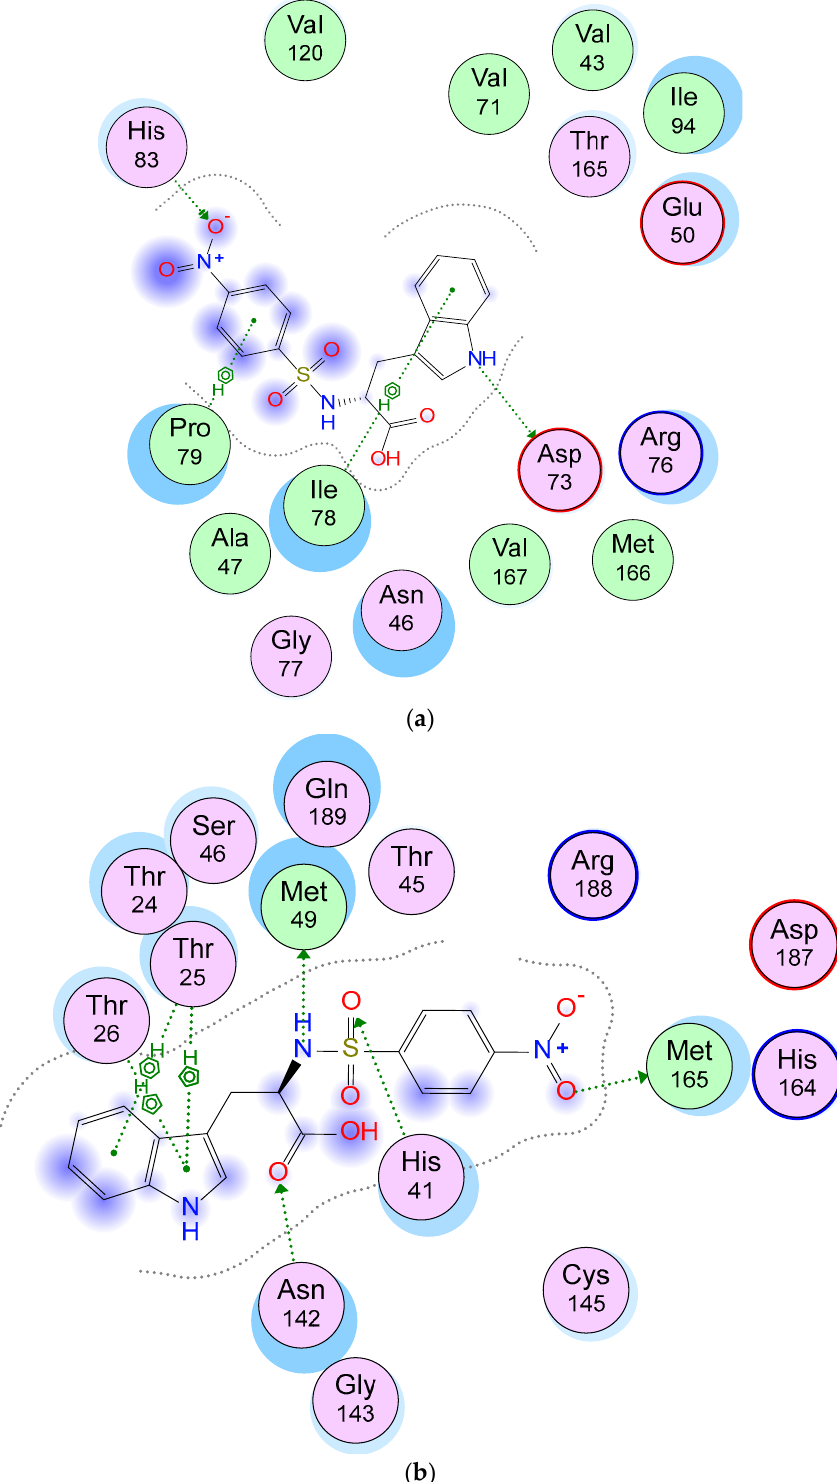
Figure 6. ( a ) 2D representation of the binding interactions between DNSPA and 5MMN. ( b ) 2D representation of the binding interactions between DNSPA and 6LU6 .